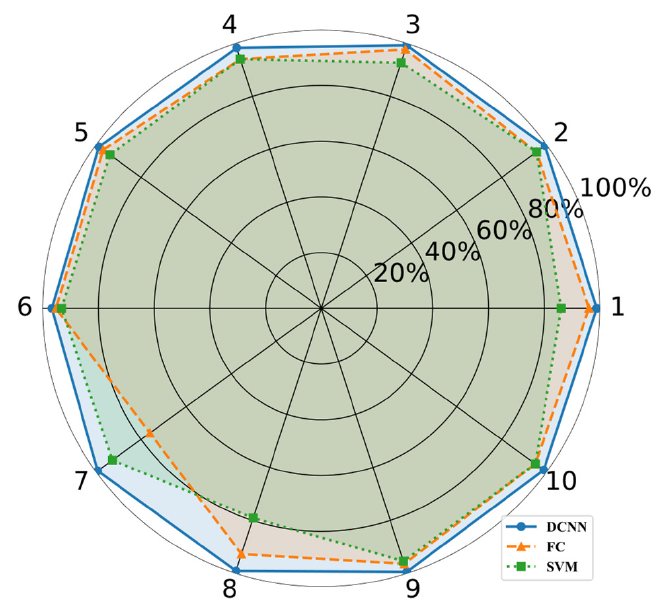
Figure 18. Ten-fold cross-validation results of the three models. Table 8. The age accuracy of the three models’ ten-fold cross-validation.